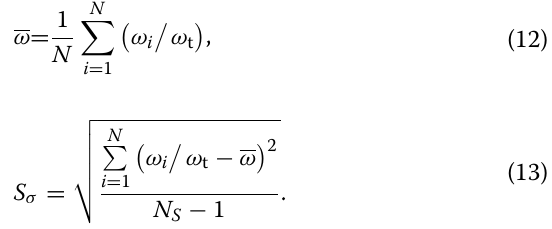
Step 3 : Generate the statistics of mode frequency of the cylindrical shell according to the samples. The MCS method is used to evaluate the probabilistic mode char- acteristics for all the sample. The mean and standard deviation of the statistical parameter can be obtained: